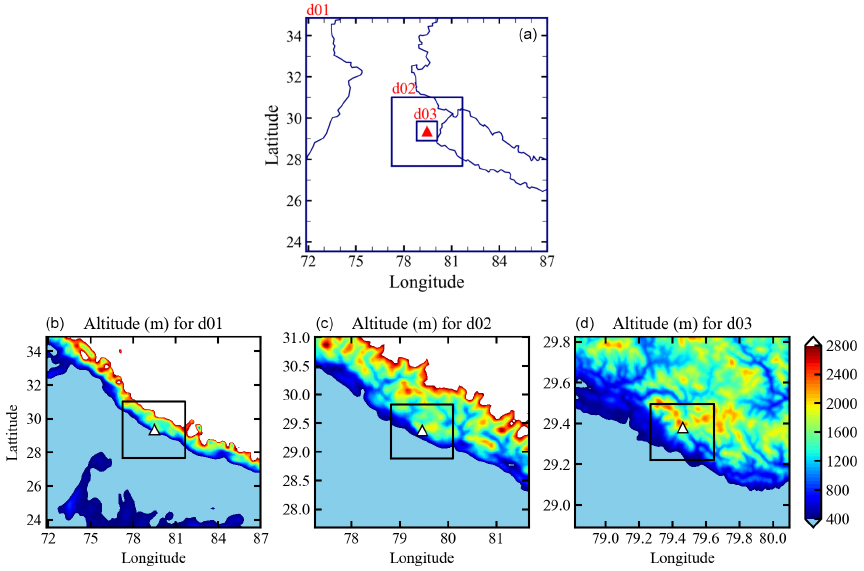
Figure 1. Topography represented in the WRF model domains (a) with three horizontal resolutions, namely domain d01 (15 × 15km), domain d02 (5 × 5km), and domain d03 (1 × 1km). Each box inside a panel corresponds to the nested domain. The triangle in the innermost box indicates the location of the GVAX campaign site, i.e., Manora Peak in Nainital. The bottom panels (b, c, d) indicate the topography of each individual domain (left to right). The finest nest inside d03 (d) is d04 at the resolution of 333m (discussed in Sect.